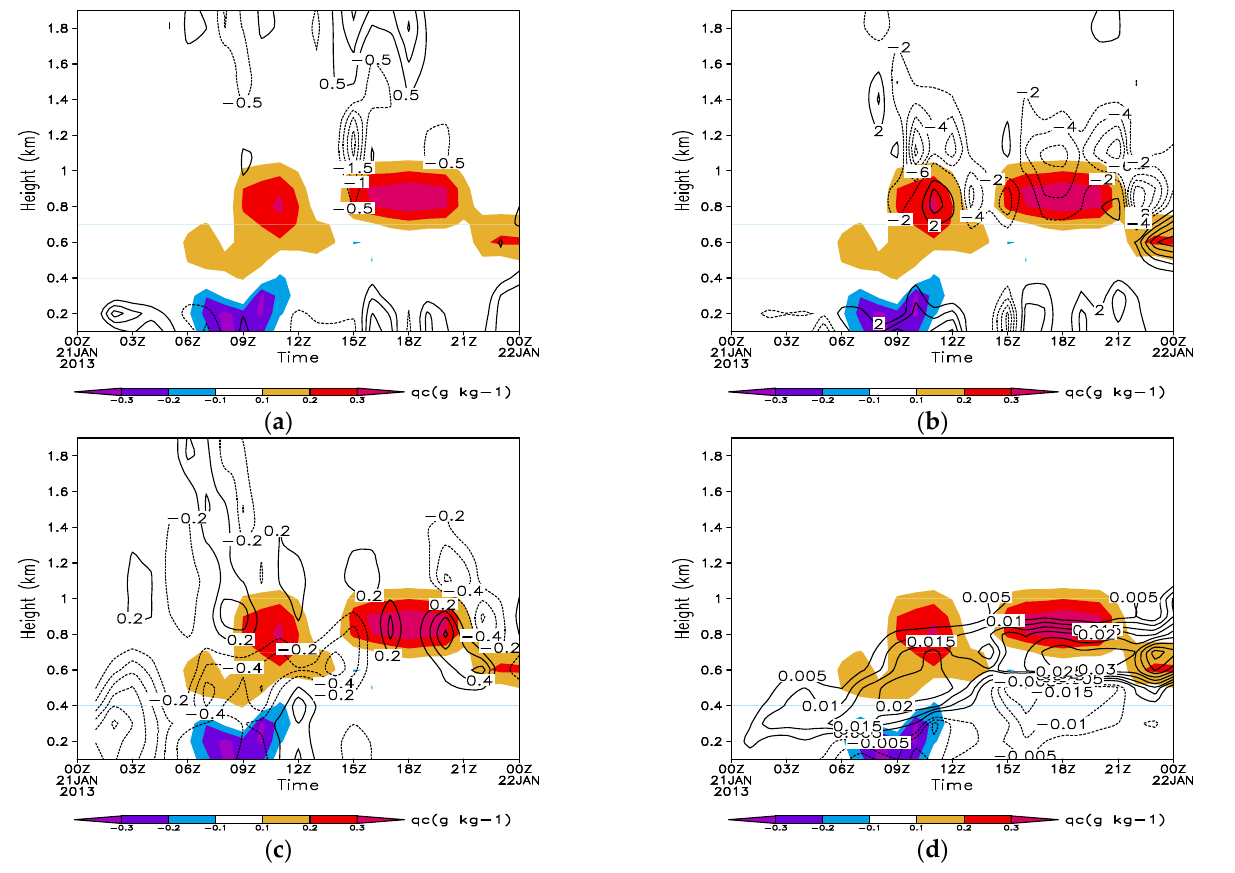
Figure 6. Regional average time-series difference diagram of the contribution of three effects to relative humidity (contour, units: × 10 − 5 s − 1 ) in the sensitivity test of the central Yellow Sea (Exp.2–Exp.3): ( a ) advection effect in U-direction, ( b ) advection effect in V-direction, ( c ) radiation effect, and ( d ) turbulence effect (shading: difference in cloud water mixing ratio, units: g kg − 1